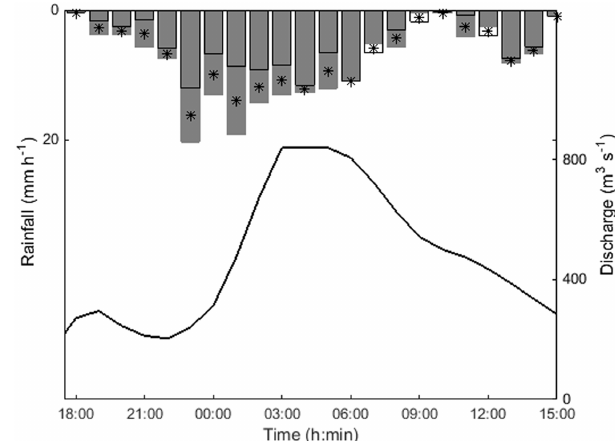
Figure 3. Hourly rainfall on 30–31 October 1998 at SMN station (grey bars), UNAH station (black outlined bars), average of the two stations (asterisks), and measured outflow at Concepción reservoir (continuous